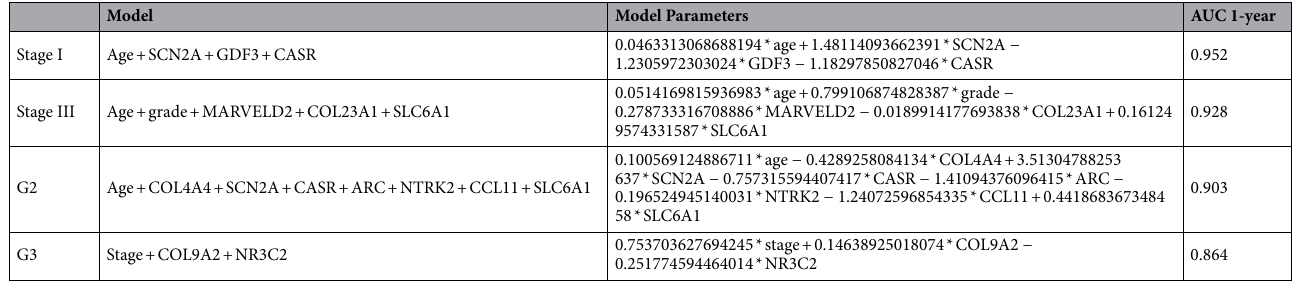
Table 2. Model construction for different grades and stages.